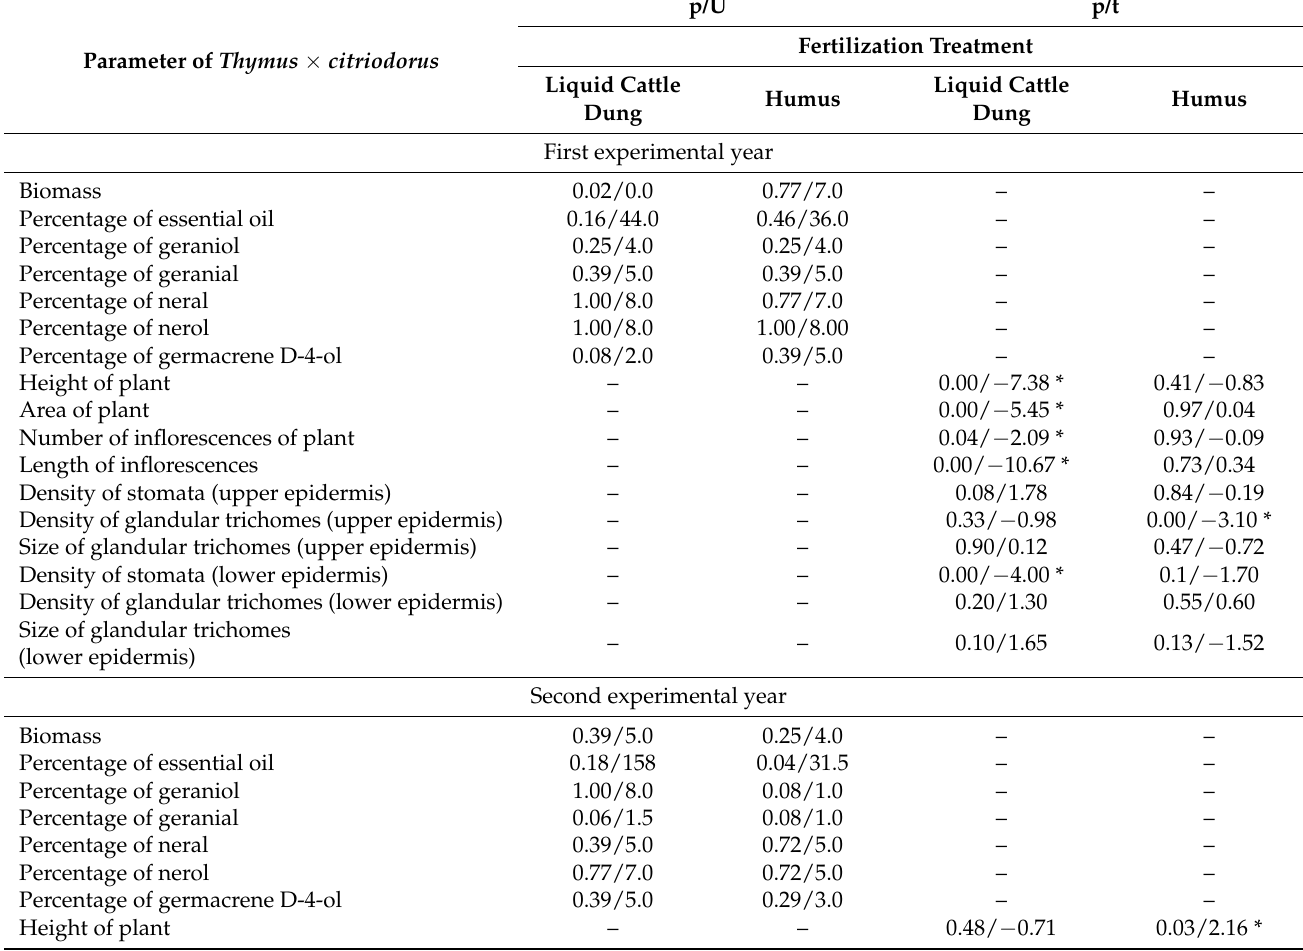
Table A2. Mann–Whiney U-test (p/U) of biomass and chemical parameters of Thymus × citriodorus and Student t-test (p/t) of morphometrical and anatomical parameters of Thymus × citriodorus. Significant level was chosen as p < 0.05; the significant differences denote *, the statistical parameter that was not analysed denote